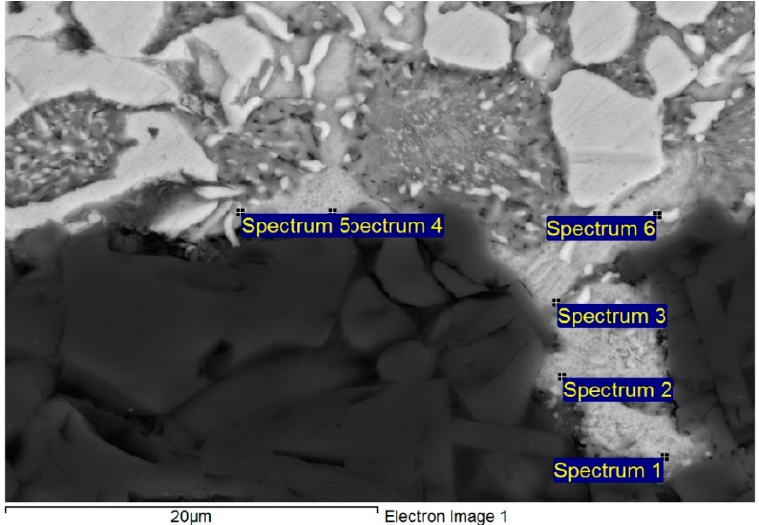
Figure 13. Point EDX analysis of boundary in Al 2 O 3 /Zn6Al6Ag joint.